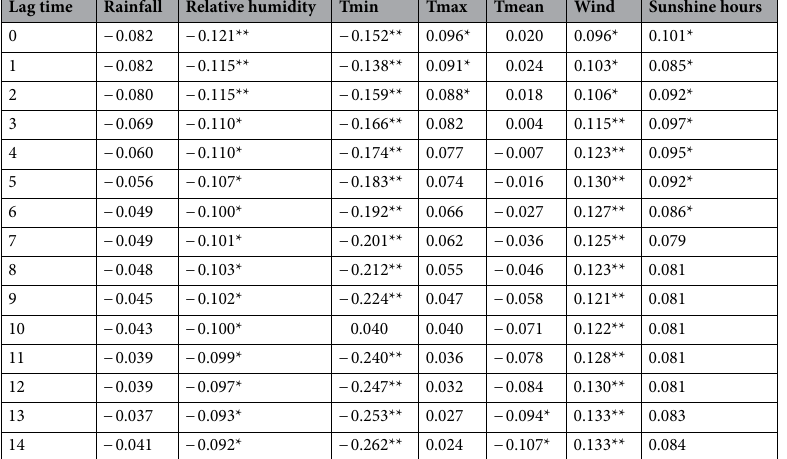
The correlation analysis revealed that minimum temperature (in °C) had an inverse significant correlation with an increased strength at lag 14 days prior to detection compared to the rest lag periods with the occurrence of daily new cases of COVID-19 (− 0.262, p < 0.01), conversely, the maximum temperature had a non-significant direct relationship with the occurrence of daily confirmed COVID-19 case except for lag 0 (day of detection) to lag 2 days. The strength and statistical significance between minimum temperature (r s = − 0.262, p < 0.01), mean tem- perature (r s = − 0.107, p < 0.05), wind speed (r s = 0.133, p < 0.01) and daily confirmed COVID-19 positive cases increased as cumulative lag period increased (Table 2). However, among the climatic factors only maximum temperature (up to 2 days lag period) and sunshine duration (up to 6 days lag) had a statistically significant relationship with daily confirmed COVID-19 positive cases in Addis Ababa. The lag periods between minimum temperature, relative humidity, wind, sunshine duration, and daily confirmed COVID-19 positive cases showed a weak statistically significant correlation for most of the lag periods at a 5% significance level. Conversely, rain- fall, maximum and minimum temperature showed an absence of a statistically significant correlation with daily confirmed COVID-19 positive cases for most of the lag periods (Table 2). Effects of climate variables on daily confirmed positive COVID‑19 cases. Table 3 shows the results of a log-link negative binomial regression model that indicates the associational effect between daily confirmed positive COVID-19 cases and the meteorological factors such as, mean daily temperature, rainfall, relative humidity, sunshine duration, and wind speed. From the analysis of the log-link negative binomial regression model, among the five climate parameters, none of them had a statistically significant effect on daily confirmed COVID-19 cases on the day of detection (lag 0) or at 2 lag days prior to detection (i.e., when transmission probably occurred). The results further indicate that among the climate factors included in the study, mean temperature and sun- shine duration had no significant role in COVID-19 incidence for all lag days ( p > 0.05), while relative humidity had a positive effect on increasing COVID-19 cases for 4 and 5 cumulative lag days prior to the detection of COVID-19 cases ( p < 0.05). A 1% increase in relative humidity was associated with 1.1% and 1.2% decreased COVID-19 cases for 4 and 5 lag days prior to detection. The magnitude of rainfall was significantly associated with the risk of daily COVID-19 cases for all lag days except for lag zero (day of detection) to 1 day (prior to detection of the virus), while an increased risk of daily COVID-19 cases was associated with the increased magnitude of wind speed for all lag periods except at the day of detection (lag 0) to 2 days. The maximum increased effect of wind speed and rainfall on COVID-19 cases was observed at the 14-day lag prior to infection detection with respective IRRs being 1.854 (95%CI 1.26–2.74) and 1.078 (95%CI 1.04–1.12). The lowest IRRs were 1.109 (95%CI 0.93–1.31) for wind speed and 1.007 (95%CI 0.99–1.02) for rainfall, both in lag 0. Overall, the negative binomial regression model analysis showed that with increased cumulative effects of rainfall and wind speed (prior to detection of COVID-19 cases), the number of positive COVID-19 cases sig- nificantly increased over the study area when considering other factors constant. This suggests that rainfall and wind speed had a great role in the transmission of the COVID-19 outbreak (Table 3).